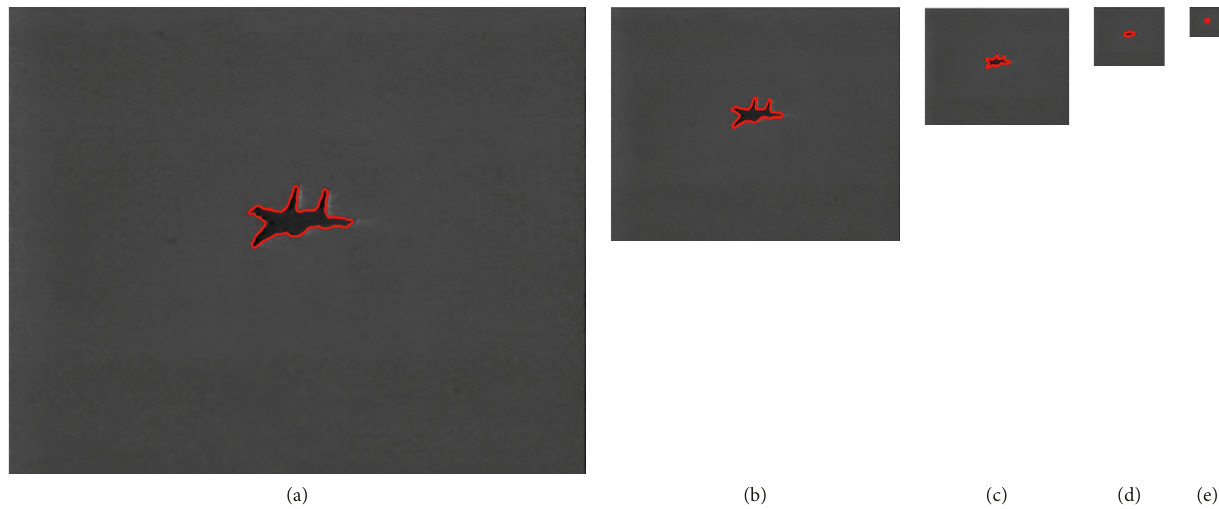
Figure 11: A set of validation experiments used to study the relationship between evolution speed and image resolution. The relevant task parameters are μ � 0 . 015, Δ t � 6 . 5, σ � 1, and ε � 2 . 5.